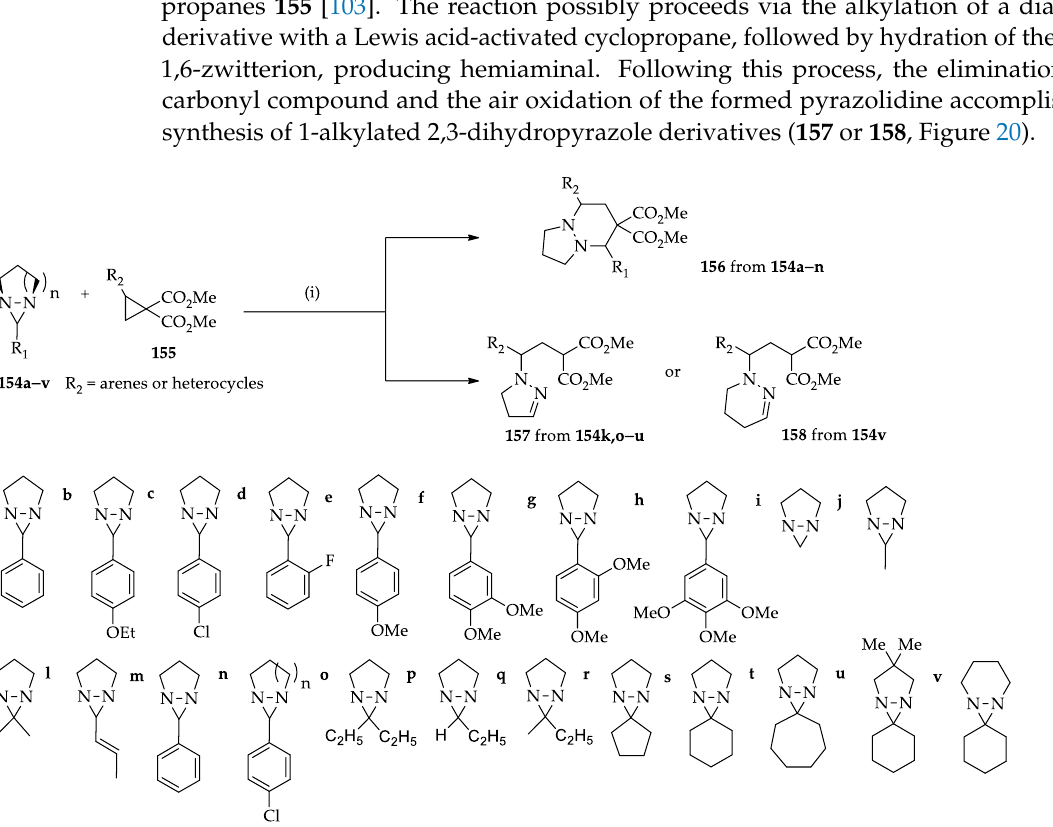
Figure 20. Bicyclic diaziridine 154a−v reaction with donor–acceptor cyclopropanes 155 . Conditions: (i) Ni(ClO 4 ) 2 ·6H 2 O, MS 4Å , CH 2 Cl 2 .